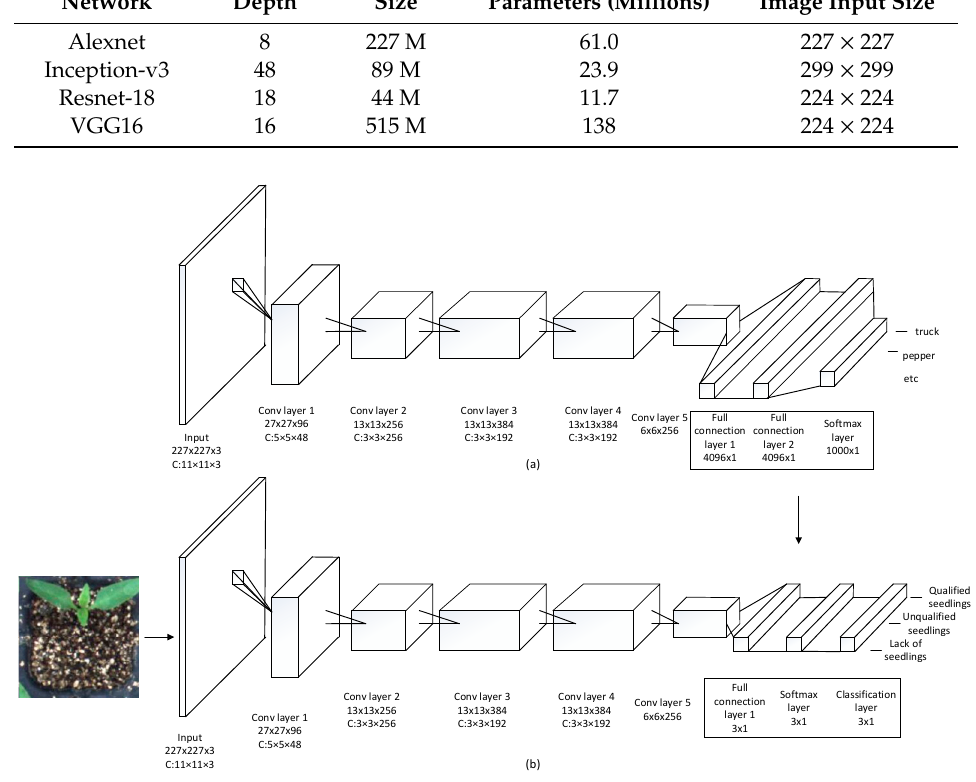
Figure 6. Alexnet convolutional neural network and transfer learning model structure. ( a ) Alexnet convolutional neural network structure. ( b ) Transfer learning model structure based on Alexnet.